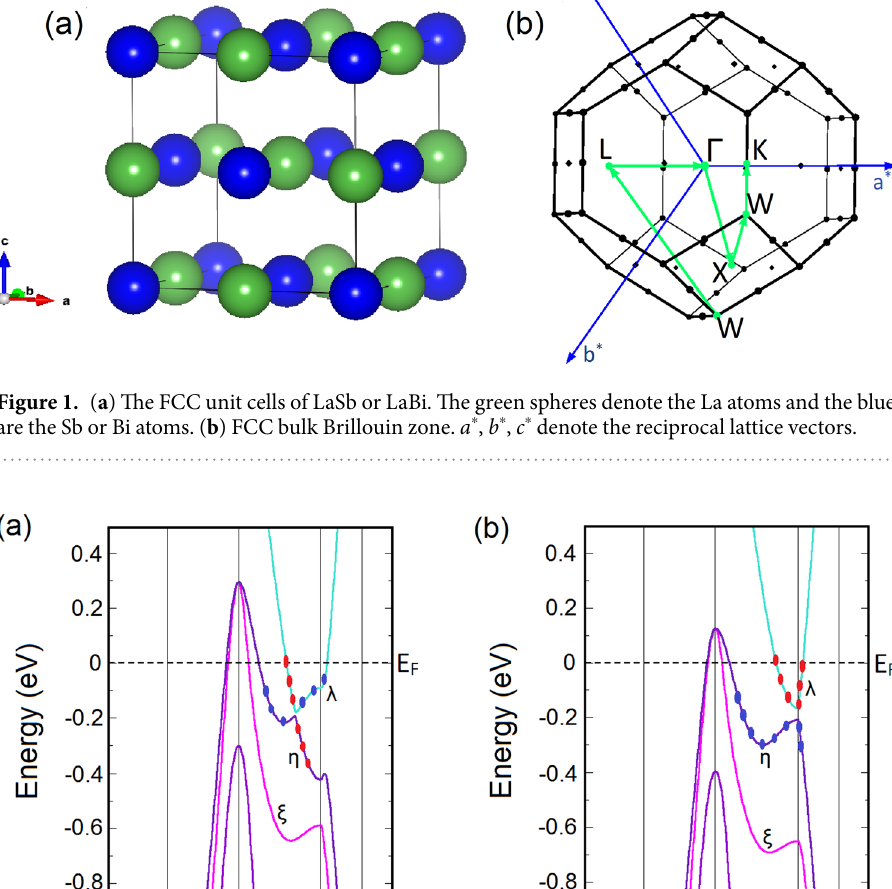
face states against TR-preserving perturbations is a signature of the topologically non-trivial nature of LaBi while we find that LaSb is topologically trivial. In section V, we consider a heterostructure made of alternating unit cells of LaSb and LaBi along the (001) direction. Presence of bulk band inversion, appearance of an odd number of gapless Dirac cones at the (001) surface, and the robustness of the surface Dirac cones to TR-preserving pertur- bations establish the topologically non-trivial nature of LaSb-LaBi multilayer heterostructure. Bulk and Surface Spectrum of LaSb Bulk band structure of LaSb. LaSb is known to crystallize in a face centered cubic structure belonging to the space group Fm m 3 (No. 225) in which the La and Sb atoms occupy (0, 0, 0) and ( ) , , 1 tively. The equilibrium lattice parameter a = 6.402 Å, obtained after volume optimization, is used for the band structure calculations. The crystal structure of LaSb and the bulk Brillouin zone are shown in Fig. 1. From the bulk band structure calculated with LDA functional, as shown in Fig. 2(a), we find that three doubly degenerate bands ( λ , η and ξ ) pass the Fermi level creating one electron pocket ( λ ) and two hole pockets ( η and ξ ). The conduction band (CB) and the valence band (VB) come very close to each other near the X point when SO is incorporated on the LDA calculation, thus giving rise to a band inversion between the Γ and X point. CB and VB change their orbital characters while crossing the point of band inversion. Contribution to the band inversion comes from the parity even La-5d orbitals and the odd parity Sb-5p orbitals as obtained from the band character plots (Fig. 2).